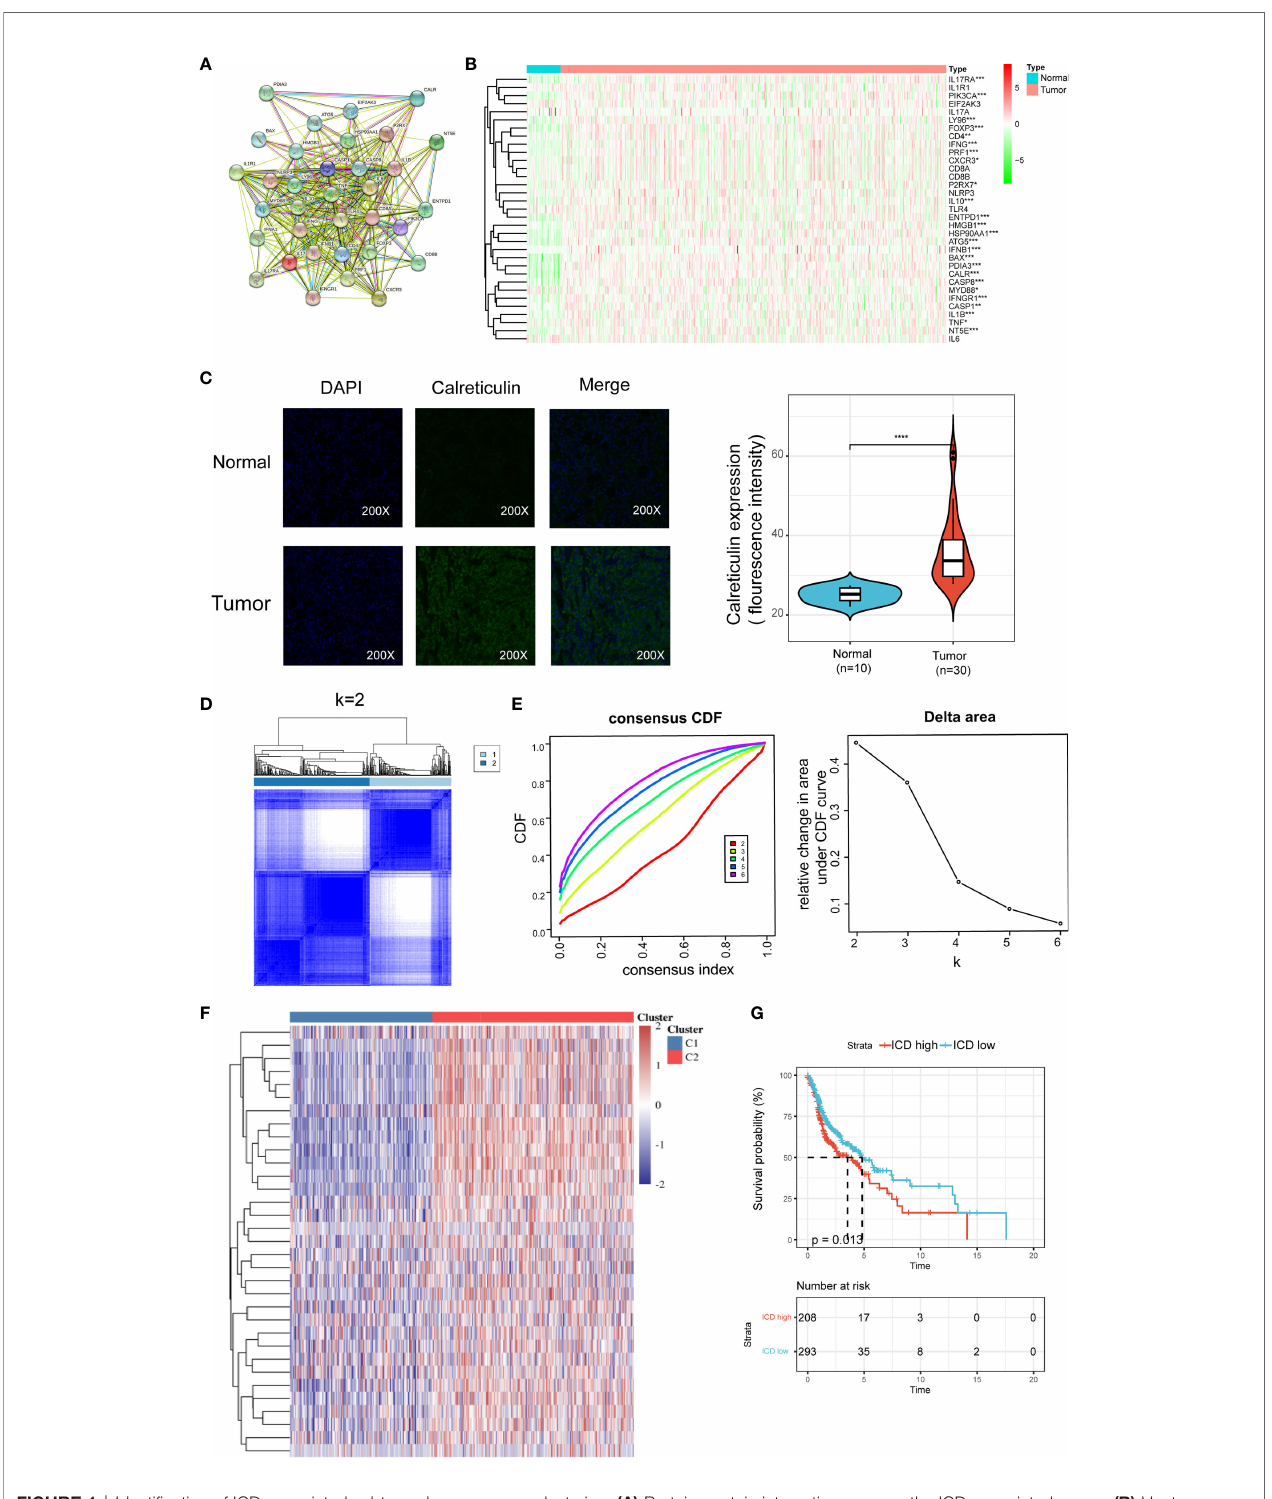
FIGURE 1 | Identi fi cation of ICD-associated subtypes by consensus clustering. (A) Protein – protein interactions among the ICD-associated genes; (B) Heatmap shows 34 ICD gene expression pro fi les among normal and HNSCC samples in TCGA database; (C) Immunohistochemistry validated the expression pattern of CALR in normal and tumor sample; (D) Heatmap depicts consensus clustering solution (k = 2) for 36 genes in 502 HNSCC samples; (E) Delta area curve of consensus clustering indicates the relative change in area under the cumulative distribution function (CDF) curve for k = 2 to 10; (F) Heatmap of 34 ICD-related gene expressions in different subtypes. Red represents high expression and blue represents low expression; (G) Kaplan – Meier curves of OS in ICD-high and ICD-low subtypes. *P < 0.05, **P < 0.01, ***P < 0.001, & ****P <